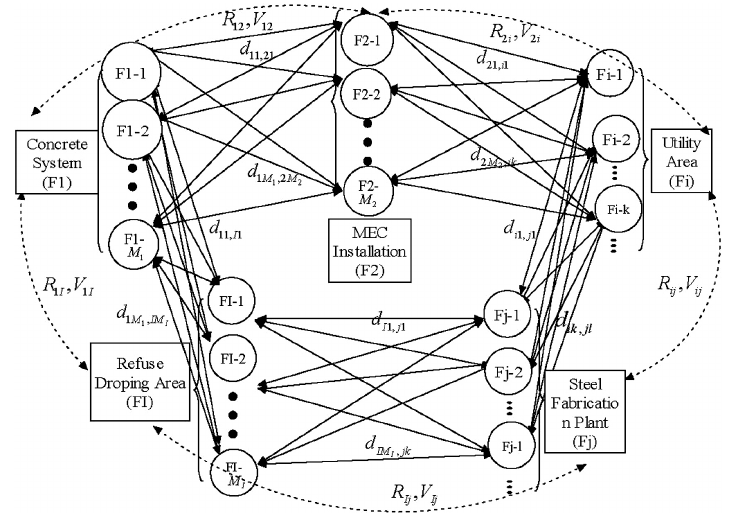
Fig. 2. The network of the